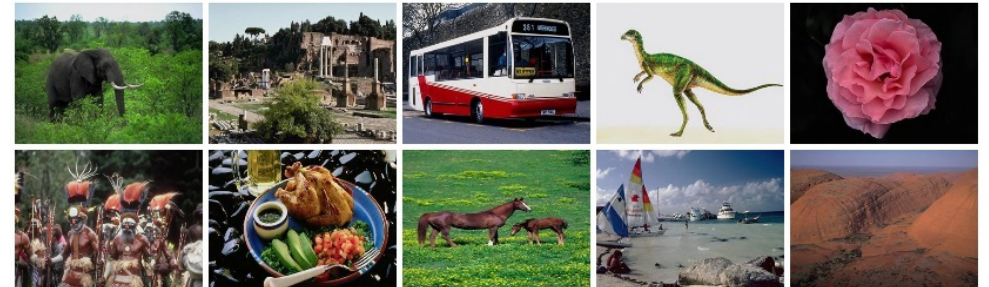
Figure 7. Sample image of each semantic category of the Corel-1000 dataset.